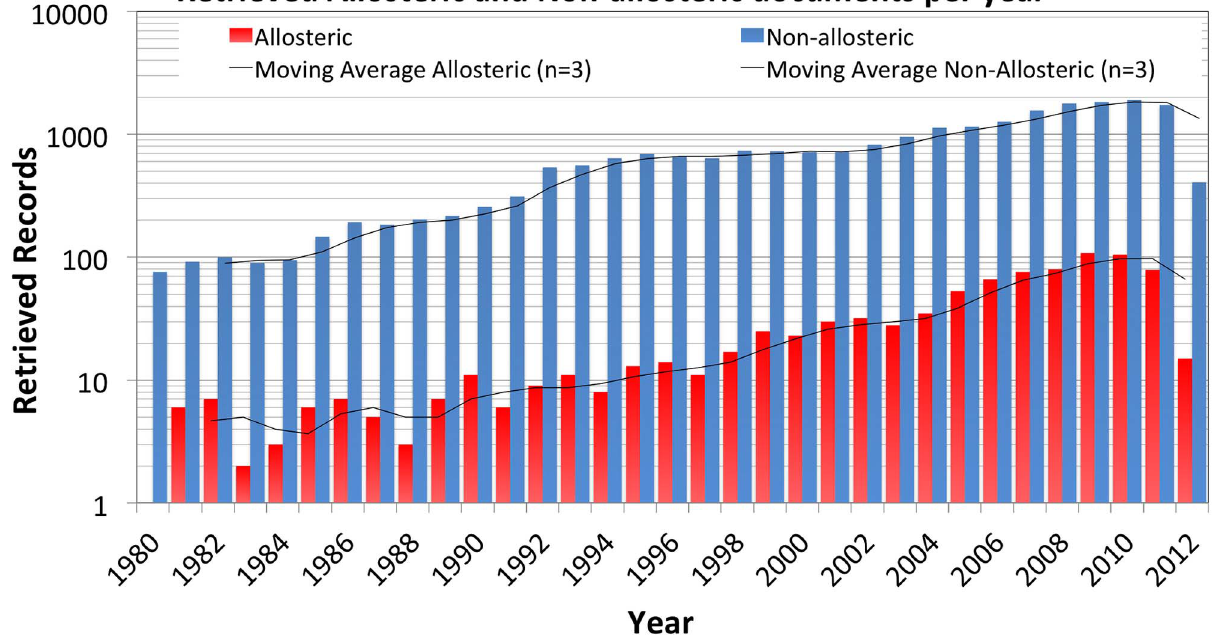
Allosteric Non-Allosteric (Balanced) Non-Allosteric (Full)